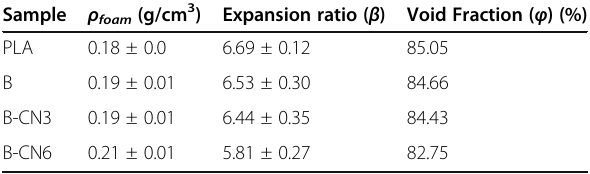
Table 2 The morphological properties of the prepared